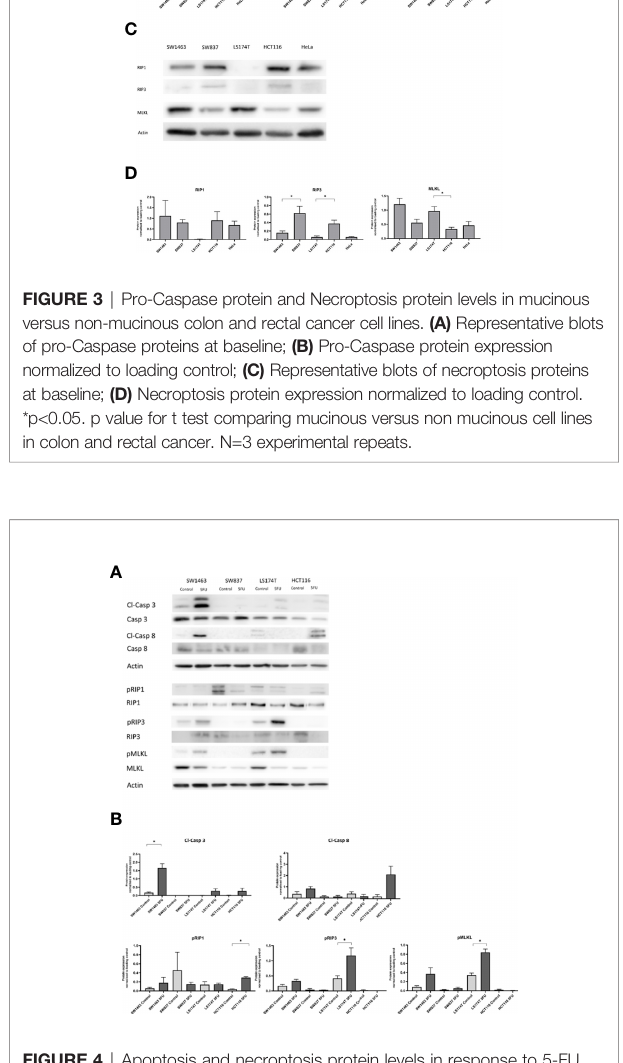
FIGURE 4 | Apoptosis and necroptosis protein levels in response to 5-FU treatment in mucinous versus non-mucinous colon and rectal cancer cell lines. (A) Representative blots of apoptosis and necroptosis proteins in response to 5-FU; (B) Protein expression normalized to loading control. *p<0.05. p value for t test comparing mucinous versus non mucinous cell lines in colon and rectal cancer. N=3 experimental